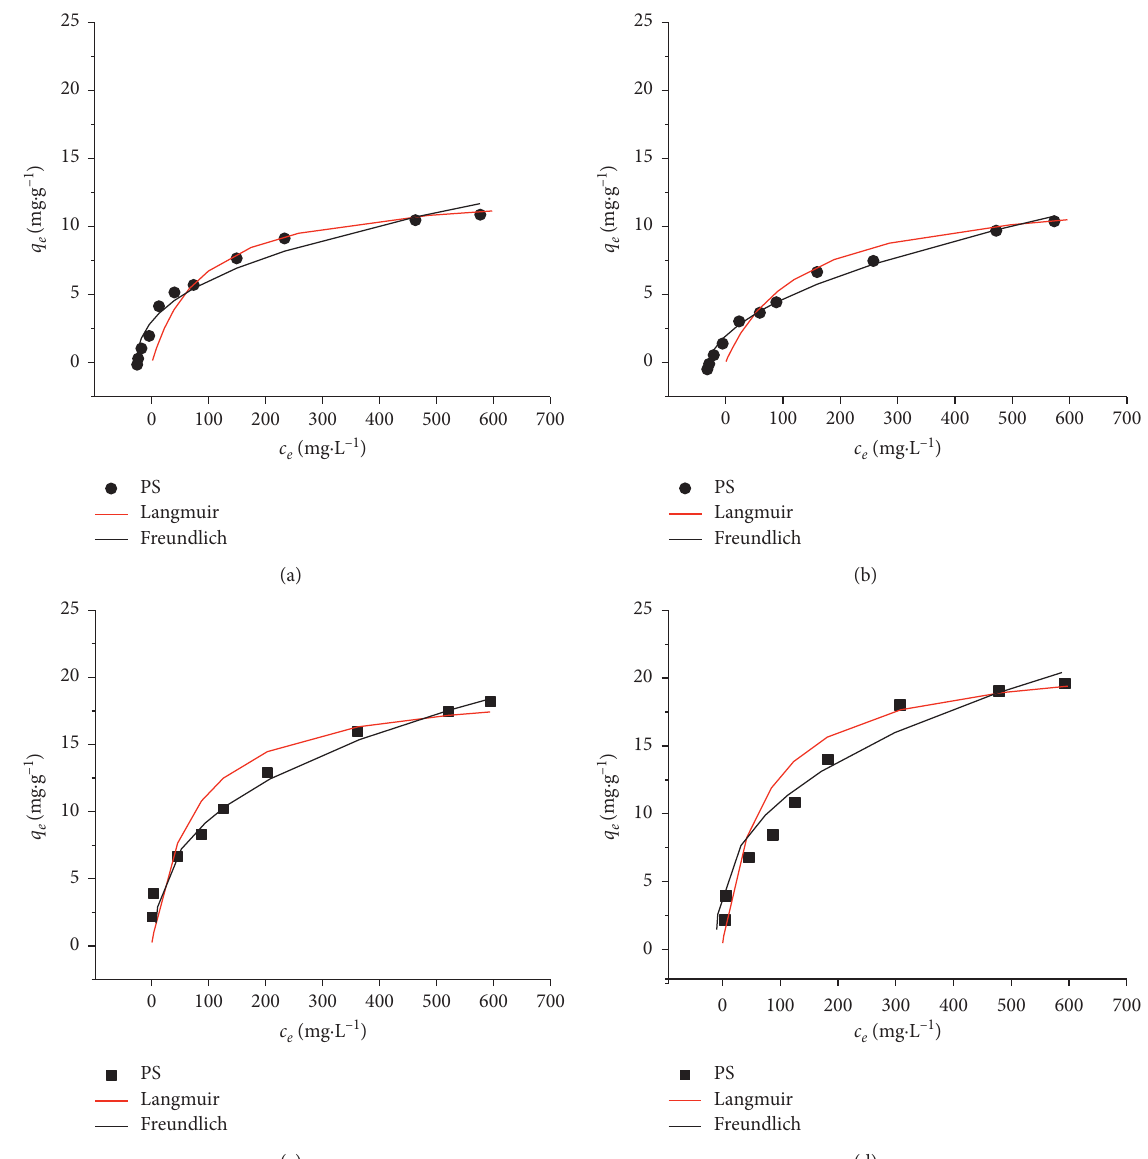
Figure 5: Effect of concentration on the adsorption capacity of PS and Na-PS towards Cd(II) (a and b) and Cu(II) (c and d) ions. Note: PS means Pisha sandstone; Na-PS means Pisha sandstone modified with Na +